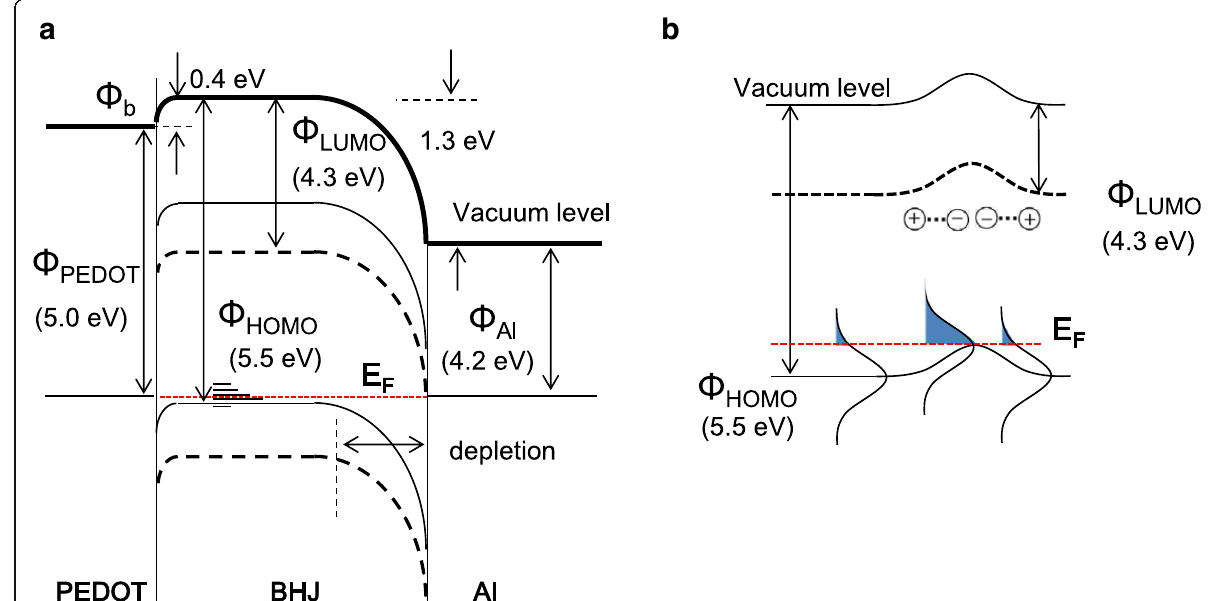
Fig. 5 a Ideal energy band diagram of measured device and b detailed view of vacuum and LUMO level band bending induced by variation of hole traps in donor